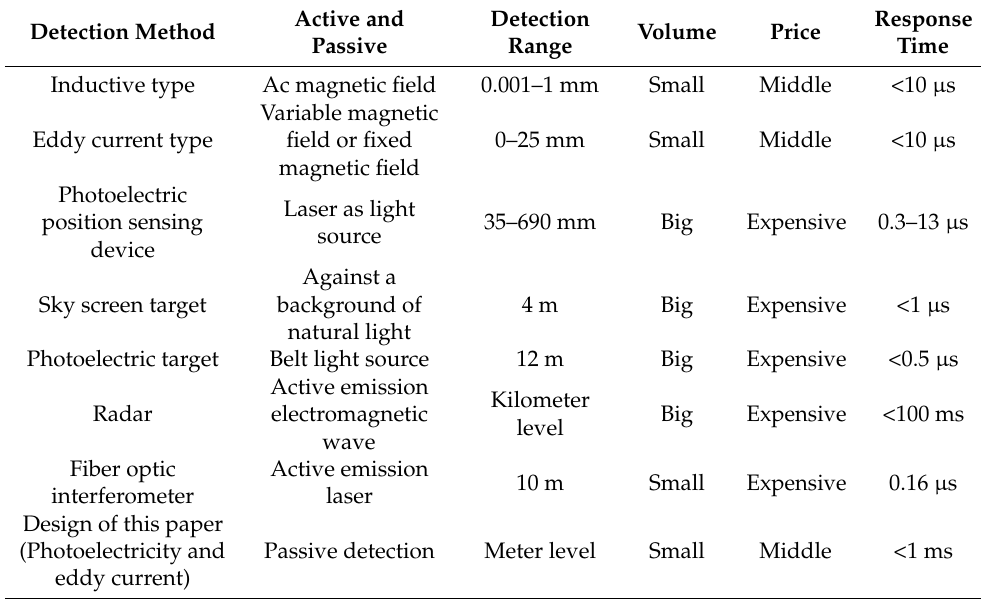
Table 1. Comparison of detection